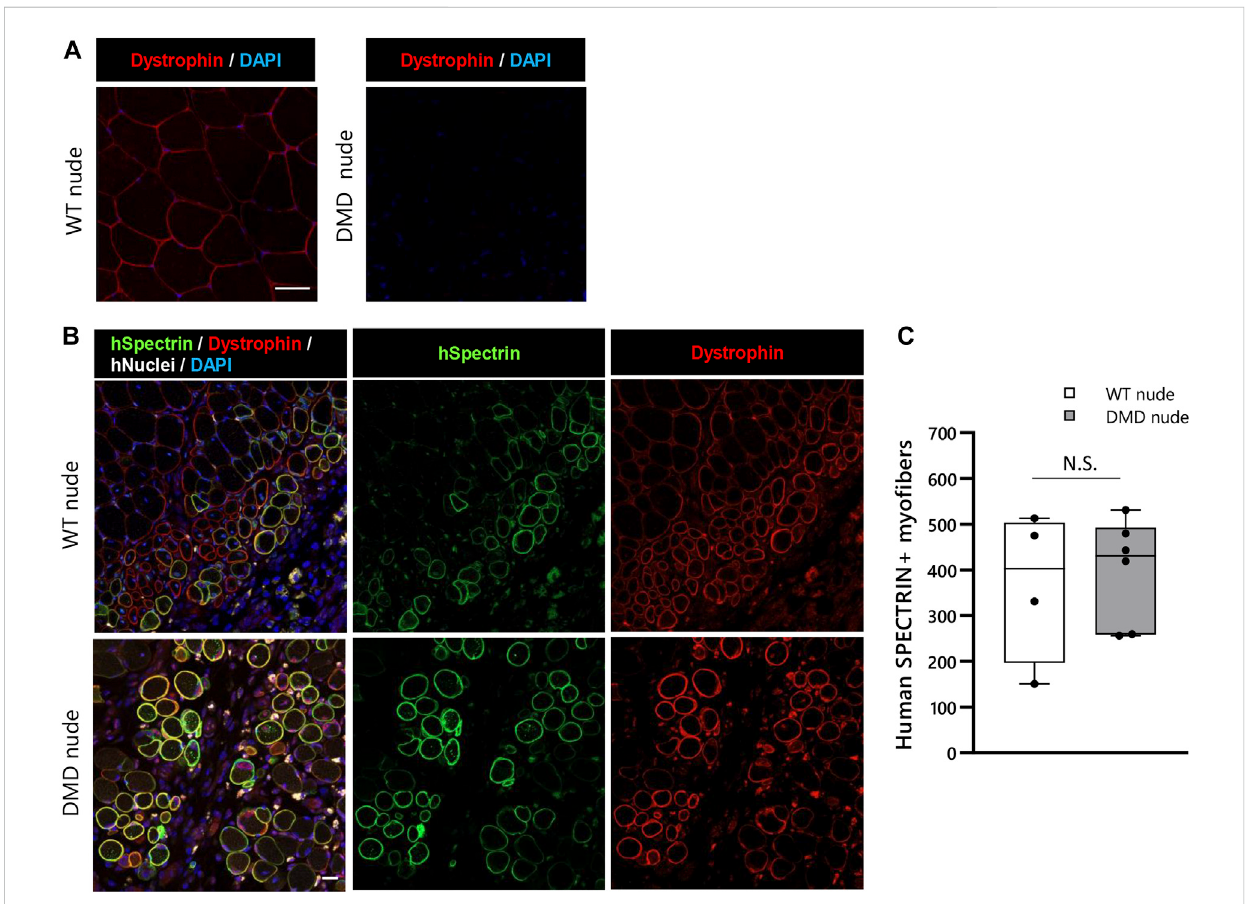
FIGURE 7 Suitability of the immunode fi cient DMD rat model for engraftment after human cell transplantation. (A) Representative images of immunostaining with dystrophin antibodies in cryosections of the TA muscle of WT nude rat. (B) Representative images showing engraftment of transplanted Hu5/ KD3 cells in 4-week-old WT and DMD nude rats. The engrafted cells were evaluated 3 weeks after transplantation using immunohistochemistry for human spectrin. Human spectrin (green), dystrophin (red), nuclei (white), and DAPI (blue). Scale bars = 25 µm. (C) The number of engrafted myo fi bers in 1 TA muscle. N.S. non-signi fi